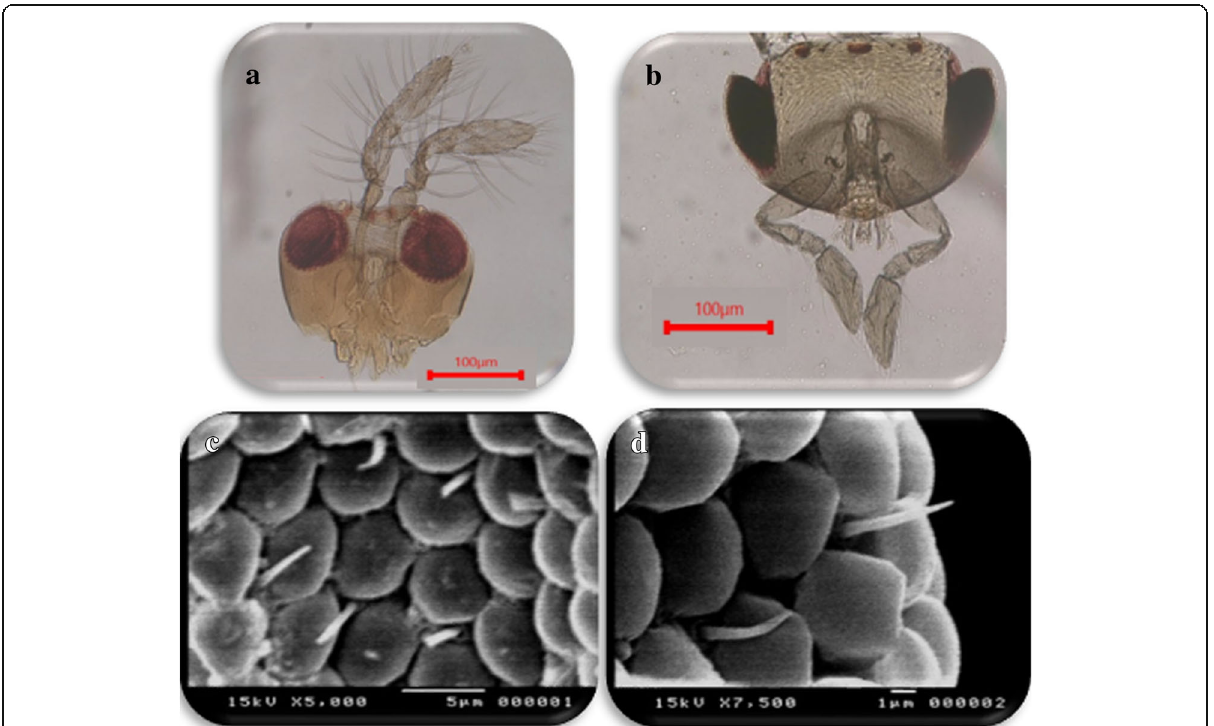
Fig. 2 The head capsule of male and female of TNV: a , b light micrograph; c , d SEM of male and female: interfacial hair in a corner between three facets